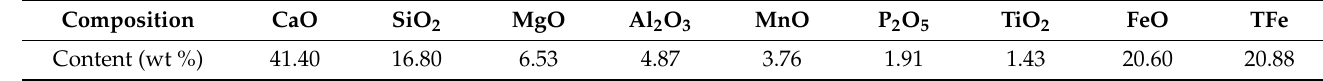
Table 1. Chemical analysis of the tested